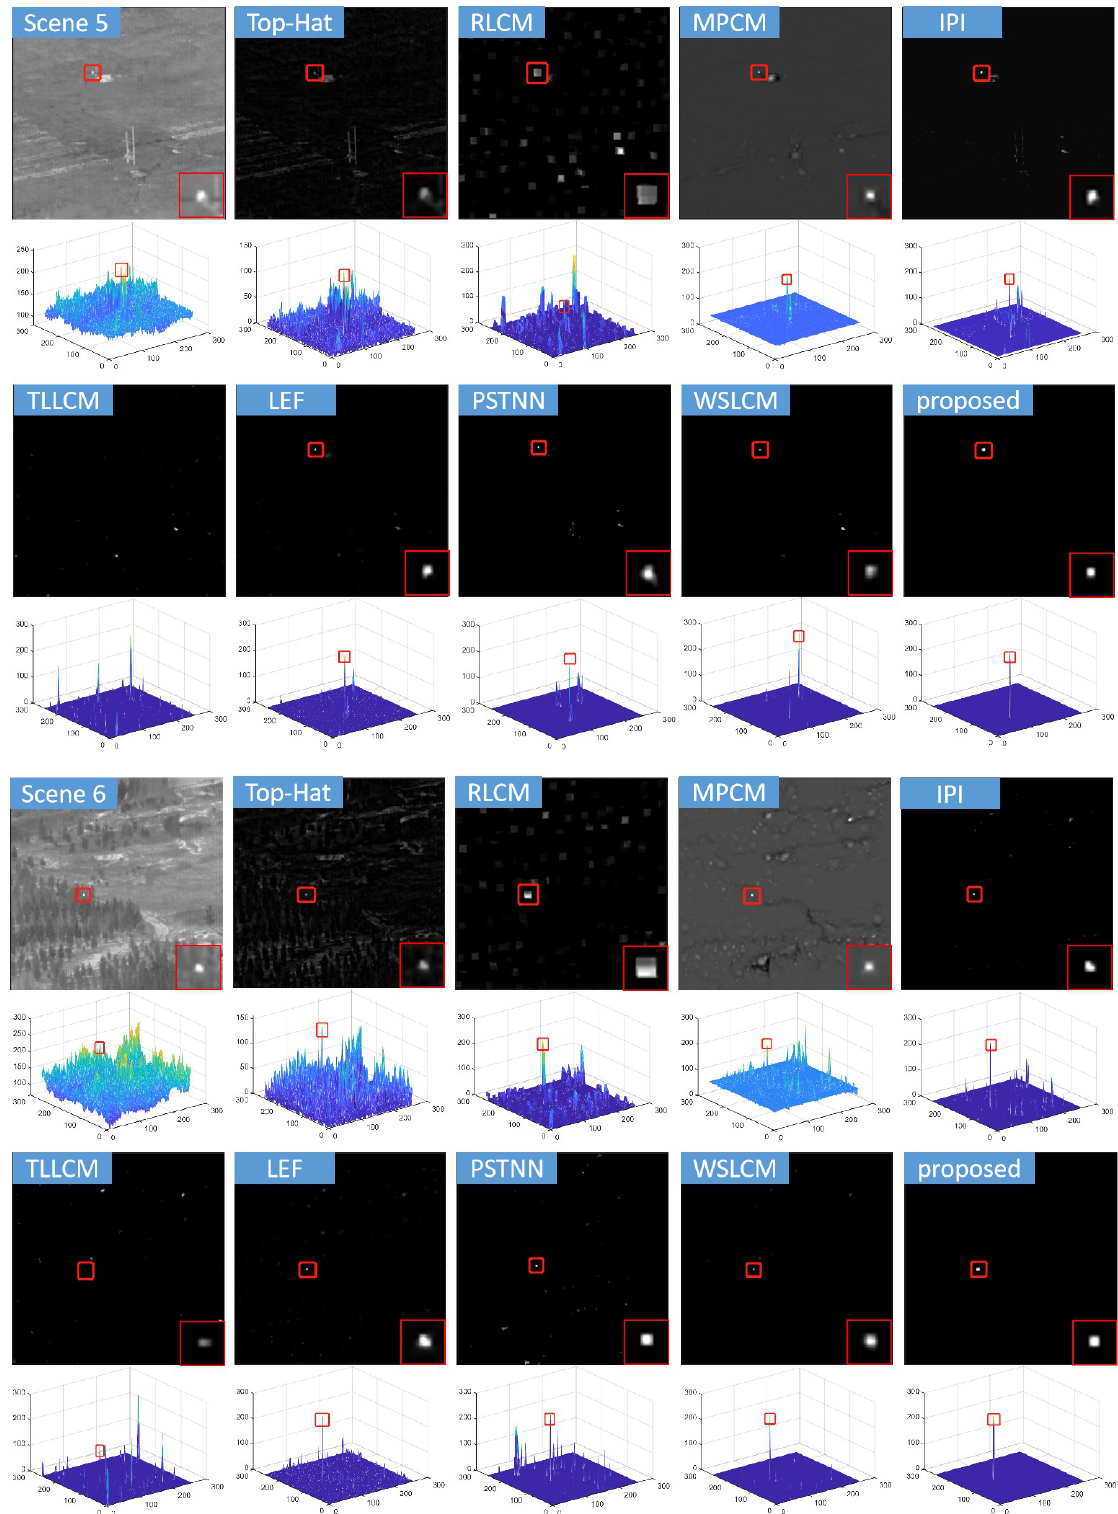
Figure 7. Detection results and 3D distribution of different methods in Scenes 5 and 6. The target is marked with a red box, and a close-up of the target is shown in the lower right corner. Unmarked areas indicate the absence of detection of the